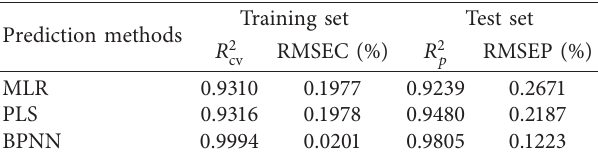
Table 4: Comparison of three quantitative prediction methods for storage years of dried Lycium